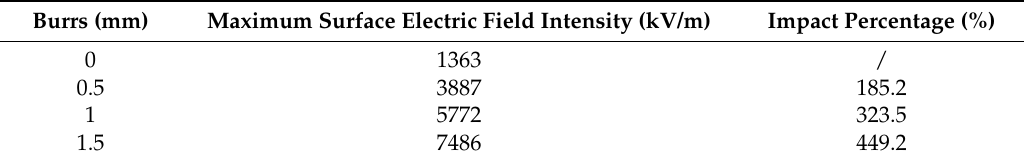
Table 3. Maximum surface electric field distribution with burrs around scratches on Φ 1.3 m.